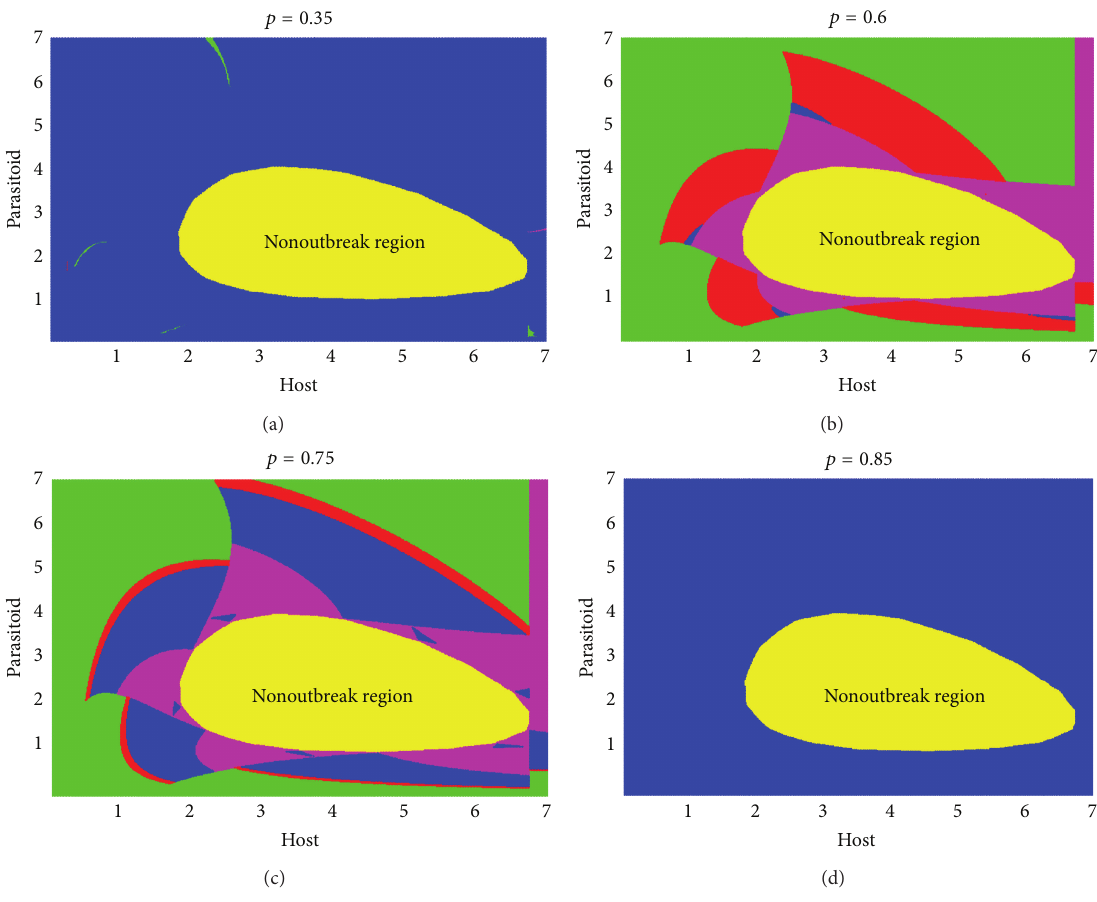
Figure 8: Compare the effect of the different killing rate of pesticides on pest outbreak frequencies. The other parameters are fixed as ET = 6.73 , 𝛽 = 0.4 , 𝜏 = 2 , 𝛼 = 12 , 𝑏 = 1 . (a) 𝑝 = 0.35 ; (b) 𝑝 = 0.6 . (c) 𝑝 = 0.75 . (d) 𝑝 = 0.85 . Different color regions corresponding to Figure